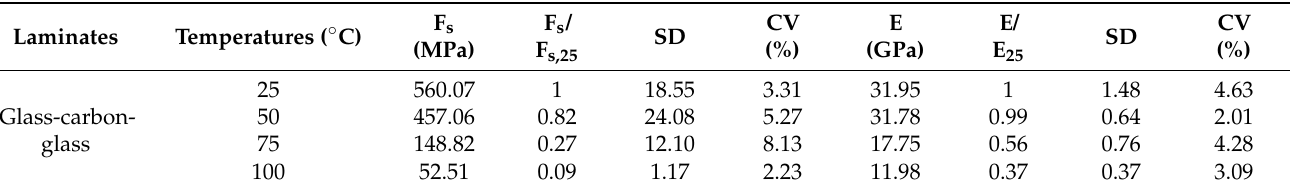
Table 6. Flexural strength (Fs) and modulus (E) properties of bidirectional glass–carbon–glass laminates under different